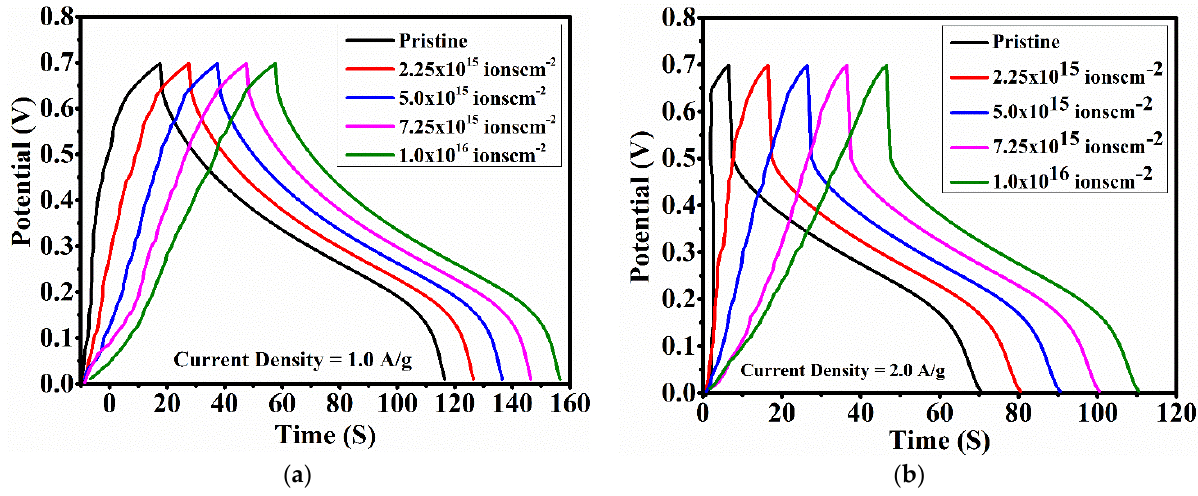
Figure 8 GCD Plots of Co 3 O 4 @MnO 2 @NiO/GO electrodes at (a) 1.0 A/g and (b) 2.0 A/g. Figure 8. GCD Plots of Co 3 O 4 @MnO 2 @NiO/GO electrodes at ( a ) 1.0 A/g and ( b ) 2.0 The cycle stability and efficiency of Co 3 O 4 @MnO 2 @NiO/GO electrode radiated with a dosage of 5.0 × 10 15 ions/cm 2 delivering a superior feature was analyzed using a current density of 1.0 A/g for continuous 10,000 cycles, as shown in Figure 9.